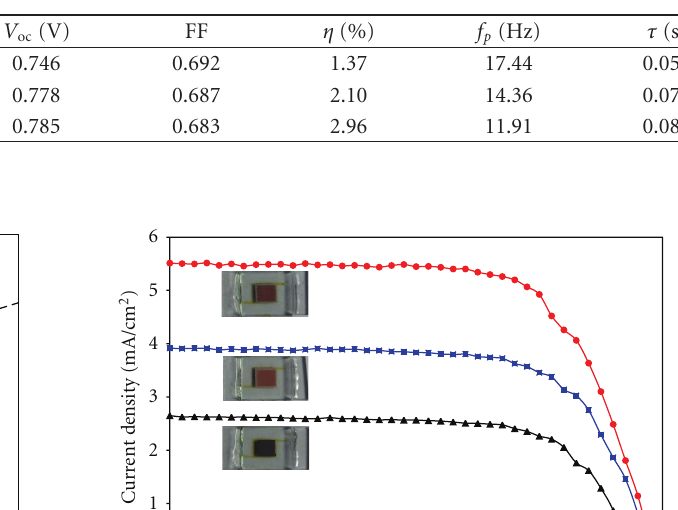
Table 1: Photovoltaic performance, peak frequency ( f p ) of middle-frequency semicircle, and electron lifetime ( τ ) of DSSCs based on di ff erent photo electrodes.